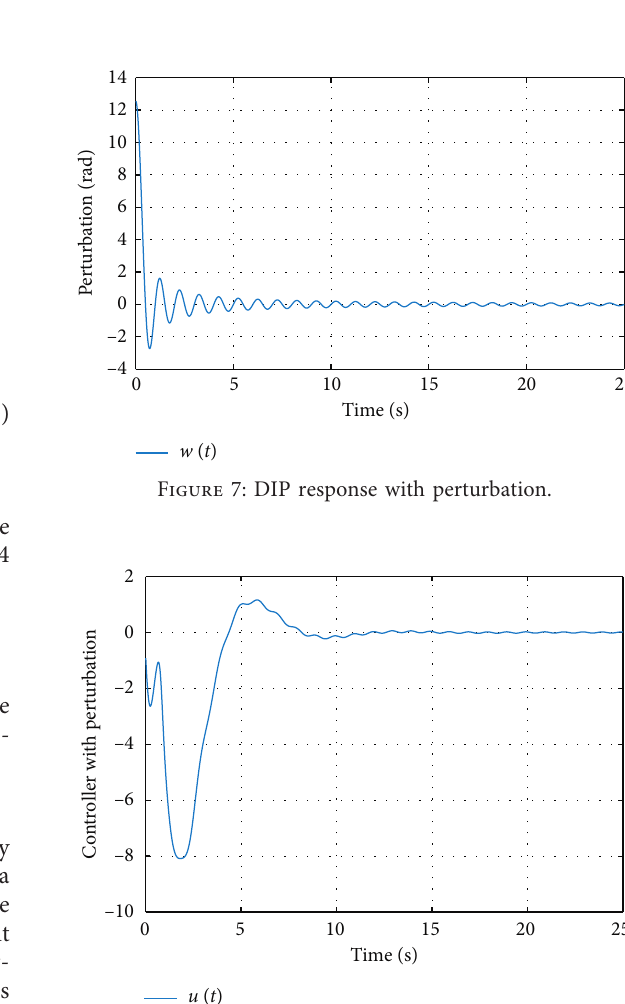
Figure 8: Applied perturbation to the DIP system.